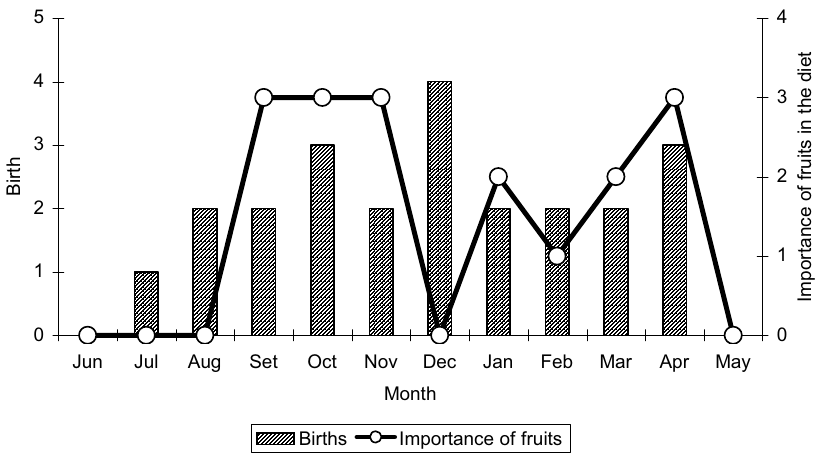
Fig. 2 – Importance of fruit in the diet and births of M. gouazoubira from 1988 to